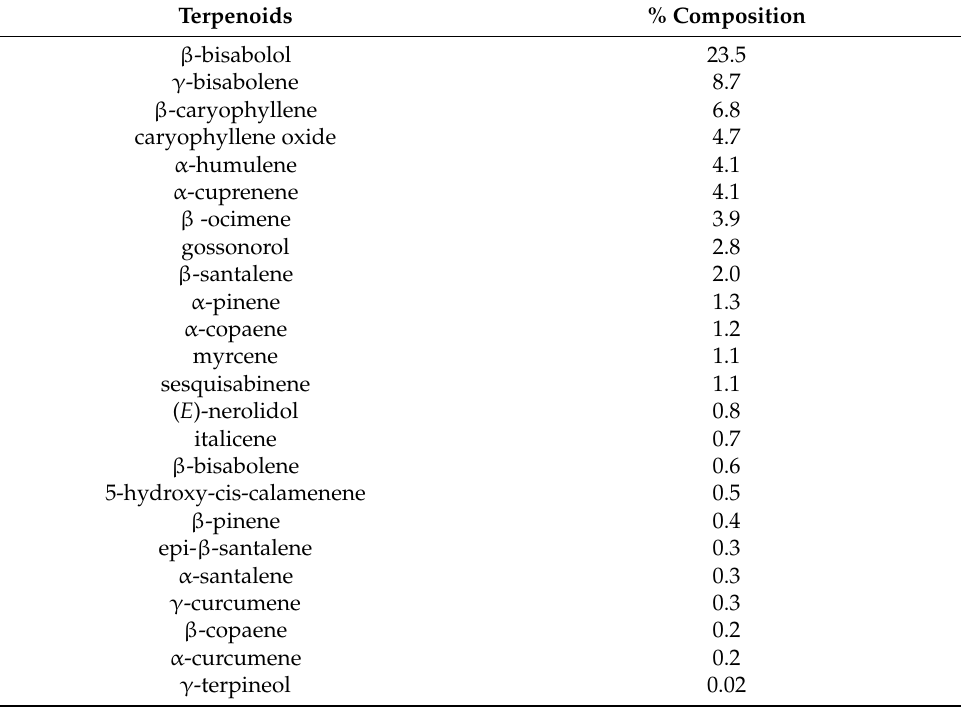
Table 1. Terpenoid composition of pesticide-free CGT oil extracted by hydro-distillation. Terpenoids % Composition β -bisabolol 23.5 γ -bisabolene